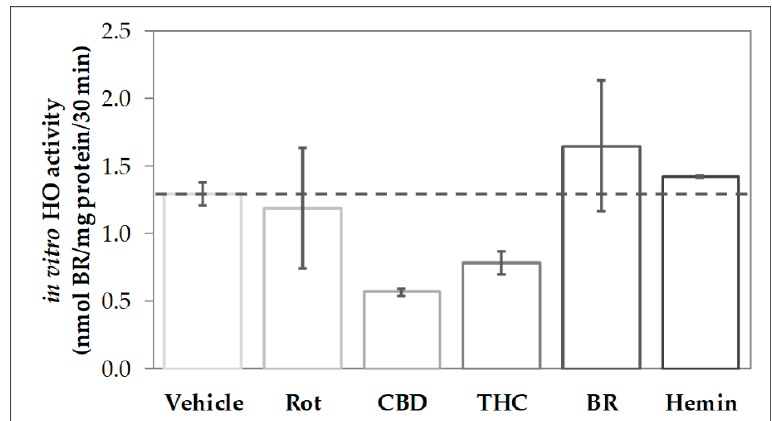
Figure 1. Phytocannabinoid treatment reduces the heme-converting capacity in primary mesencephalic cultures. Mesencephalic cultures were obtained and cultured, as is described in the Material and Methods. Cells were incubated with vehicle dimethyl sulfoxide (DMSO), rotenone (Rot, 80 nM), cannabidiol (CBD; 10 µM), tetrahydrocannabinol (THC; 10 µM), bilirubin (BR; 10 µM), or hemin (10 µM) for 48 h. Heme oxygenase (HO) activity was determined as described in Material and Methods. Each data point represents the mean ± SD from two experiments ( n = 2), which were measured in duplicates. Therefore, statistical analyses were not performed.